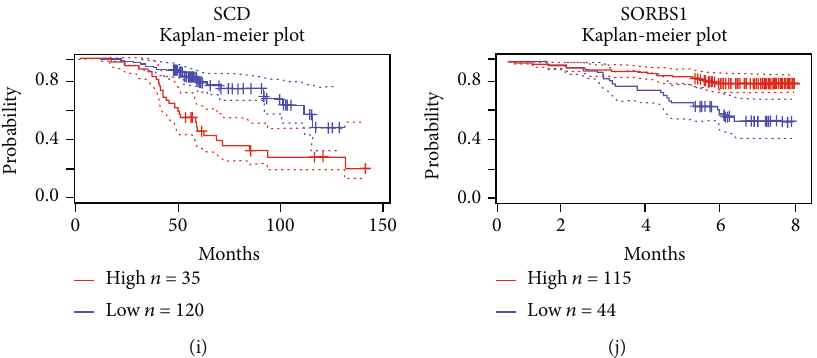
Figure 7: Overall survival curves based on risk model genes in BRCA. (a – j) APOA2, APOA5, APOC3, CPT1A, CYP27A1, MMP1, NR1H3, PLTP, SCD, and